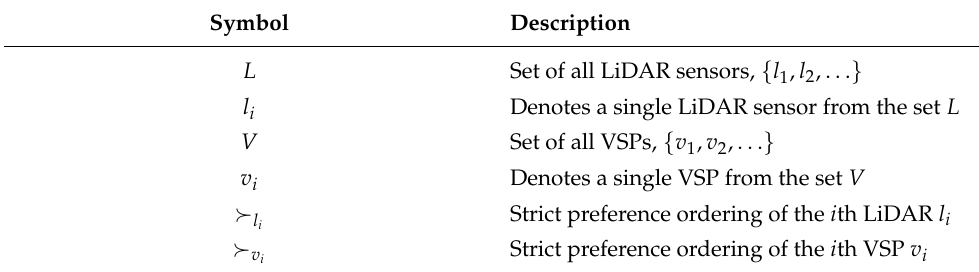
Table 3. Symbols and